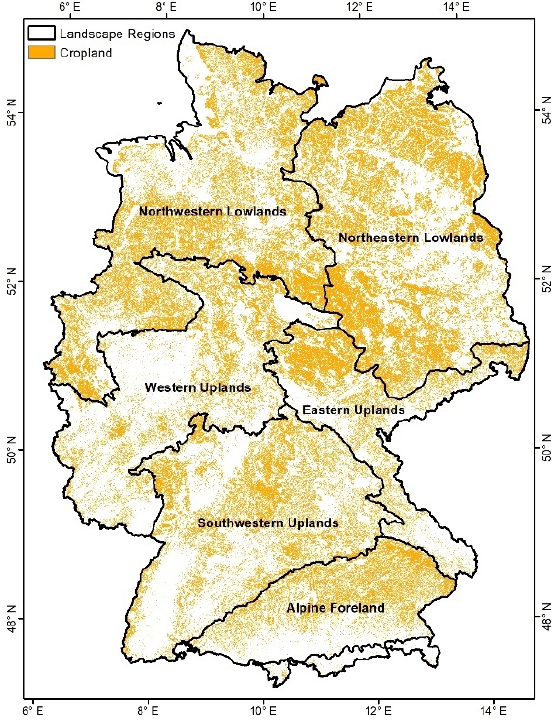
Figure 2. Cropland mask (orange) generated to delineate the crop type classification, and extent of the six landscape regions (black borders) used for the regional classification runs. In addition to the field-level validation measures calculated with LPIS data, the areas covered by crop types according to the classification map are compared to national statistics on crop acreage published by the Federal Statistical Office [1,79–81] and the Bavarian State Research Centre for Agriculture